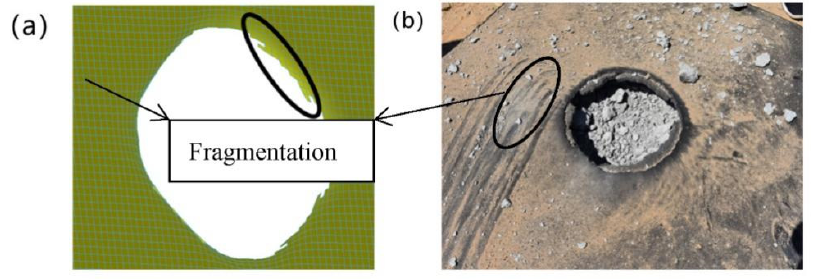
Figure 18. Failure mode of face surface blast polyurea coating: ( a ) simulated coating; ( b ) test coating.